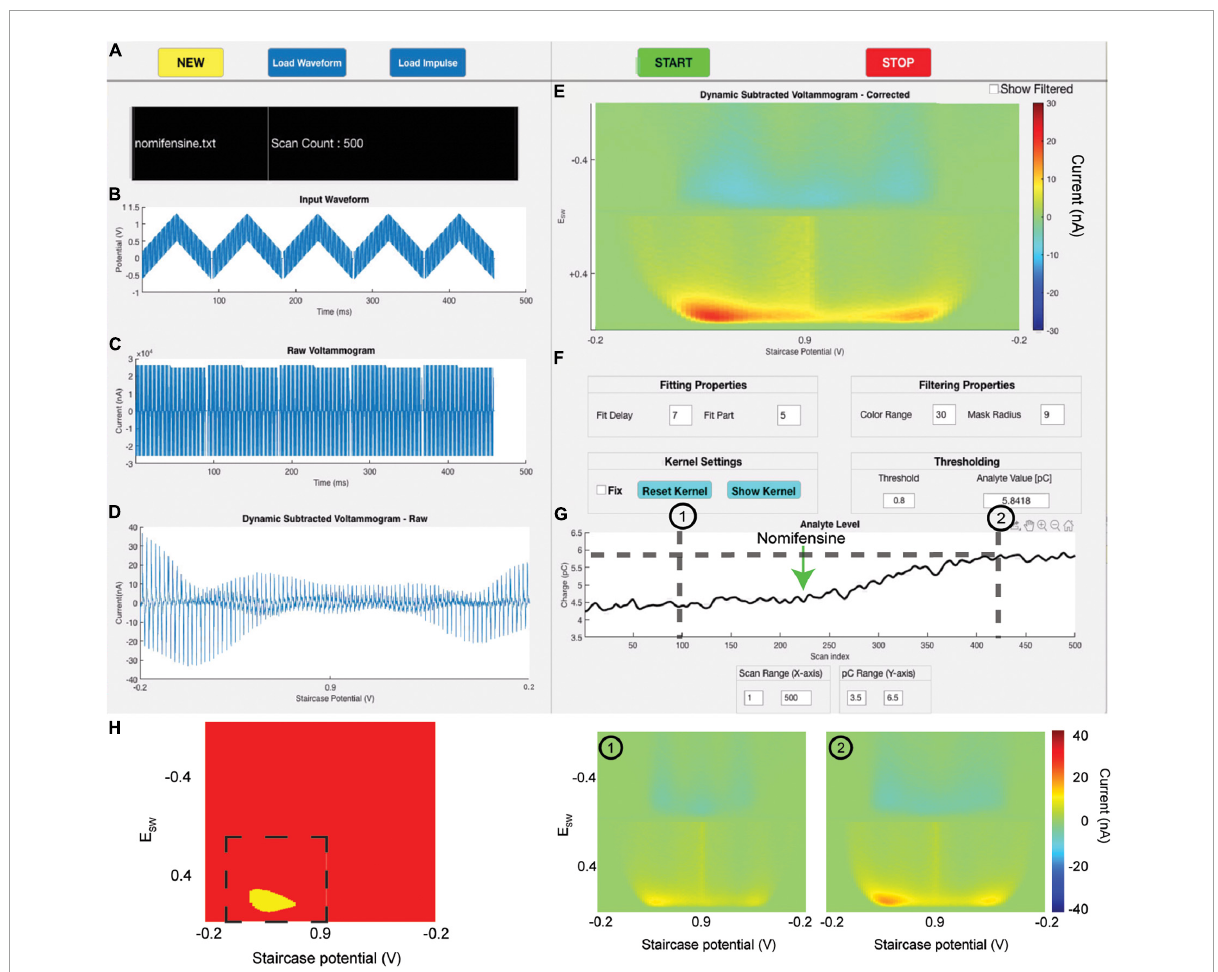
FIGURE4 Software user interface. (A) Buttons to control the GUI, output text file name, and current scan count. (B) Plot of waveform applied to the electrode at the beginning of each scan. (C) The raw redox current trace response to the input waveform. (D) Non-Faradaic-subtracted voltammogram as a function of input voltage. (E) A 3D color plot of the non-Faradaic-subtracted voltammogram plotting input voltage on the X -axis, the amount that the input voltage is swept through with each square wave on the Y -axis, and current as the intensity. The bottom half plots oxidation currents, and the left half plots current response to the upward sweep of each square wave. (F) User-defined fitting, filtering, kernel, and thresholding parameters. (G) Charge trace which tracks the analyte charge computed for each scan. For this experiment, nomifensine was administered at scan 225. (H) Left: Real-time dopamine kernel used for charge calculation. Dashed line indicates the area used for charge computation. Right: 3D color plots of pre-nomifensine (scan 175) and post-nomifensine (scan 450)